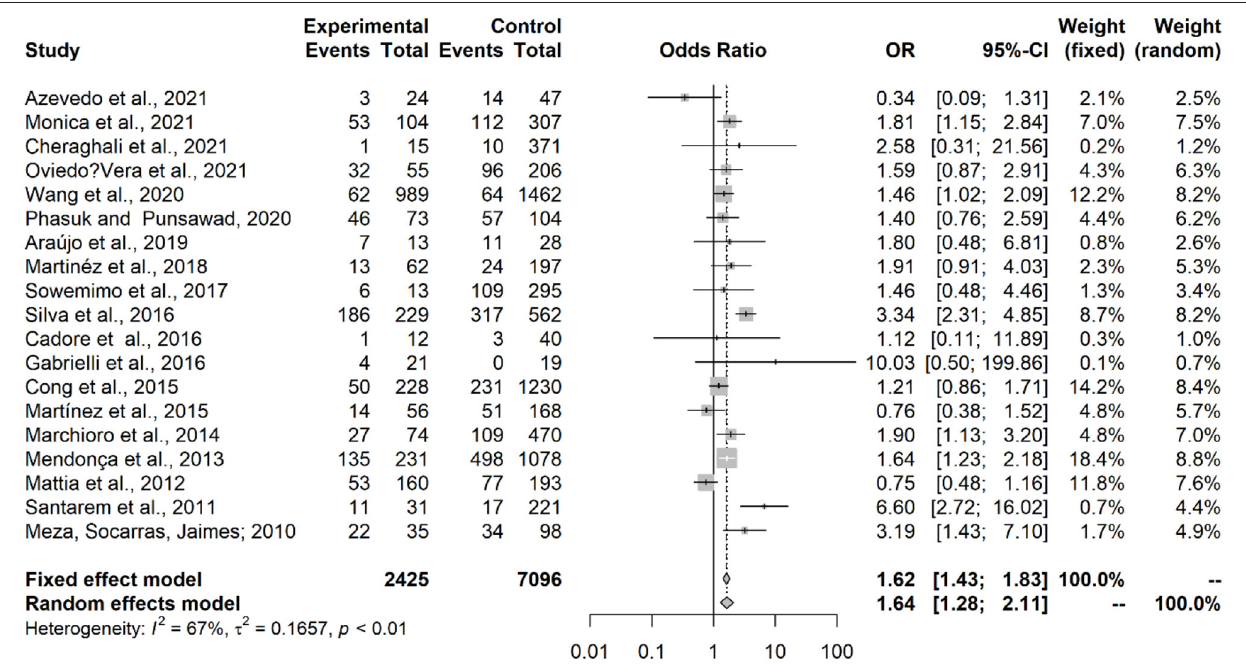
FIGURE 3 | Forest plot for assessment of odds-ratio of influence of contact with cats in the frequency of anti- Toxocara antibodies in under-18 participants, according to selected articles used in the meta-analysis from 2009 to 2021.